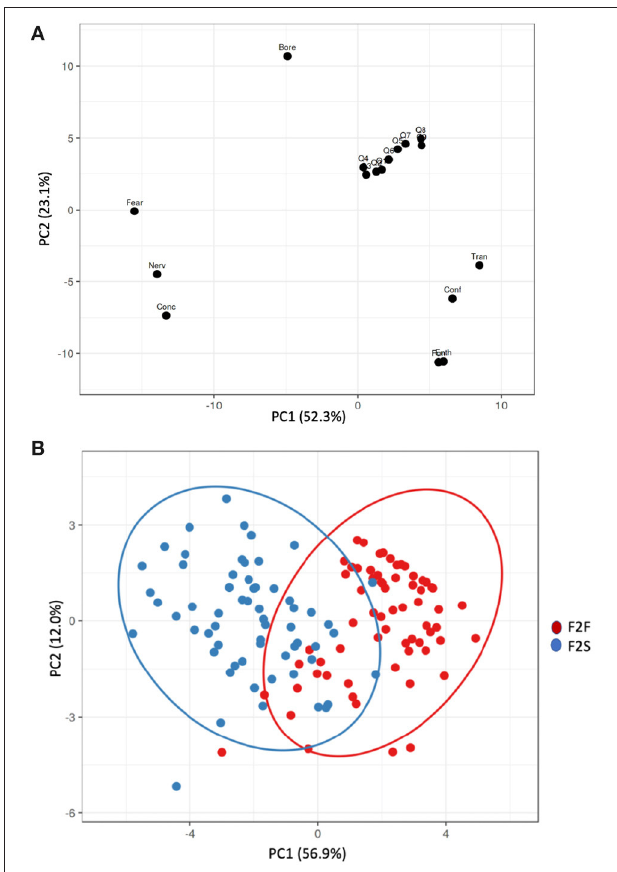
FIGURE 6 | The PCA diagram: (A) loading corresponding to the questionnaires of emotion and perception; (B) scores plots corresponding to the PSTs distribution of F2F and F2S flipped